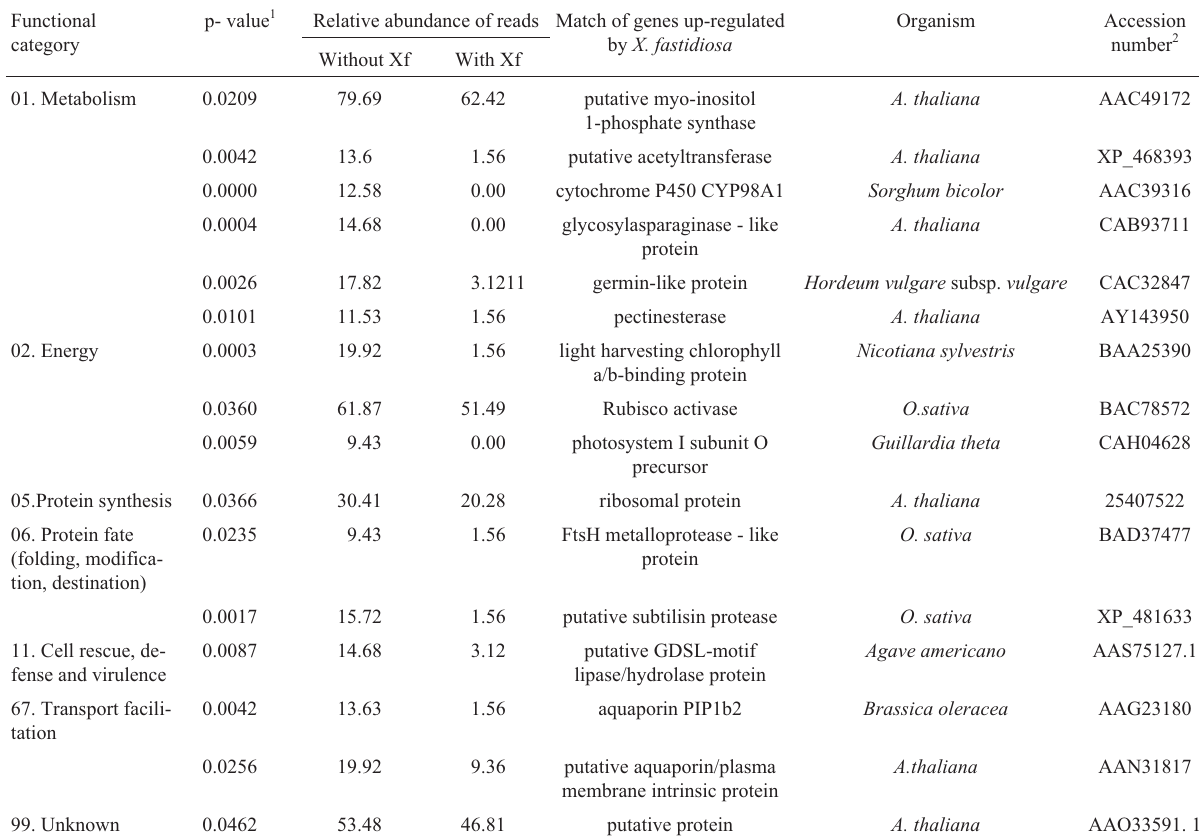
Table 1 - Functional categorization of the down-regulated genes in sweet orange plants exhibiting citrus variegated chlorosis symptoms Functional